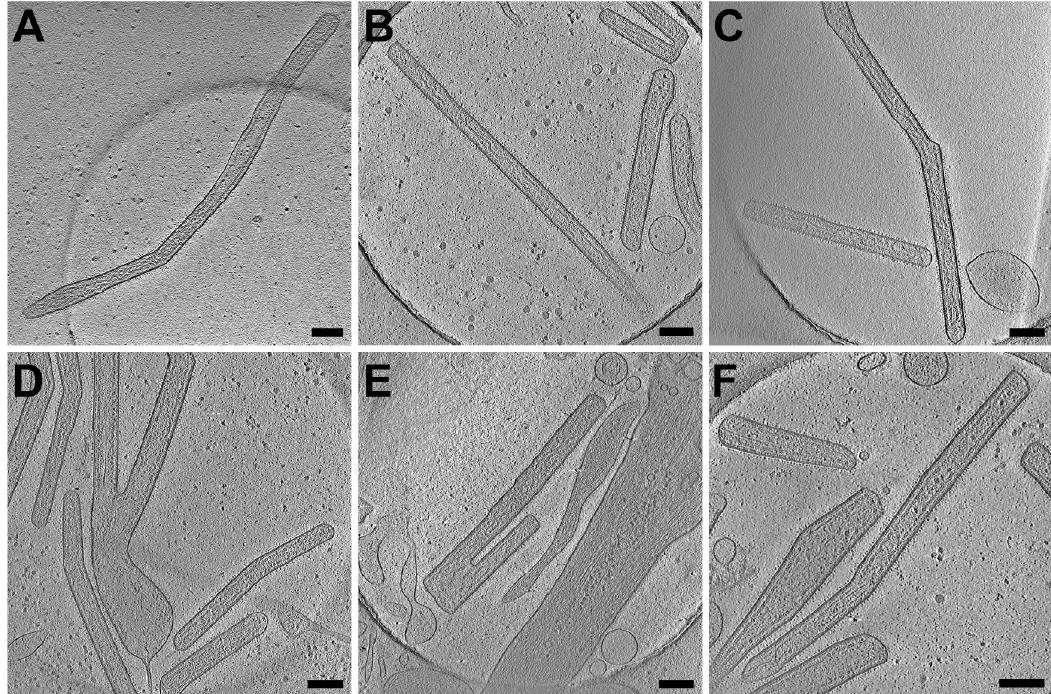
Figure 3. Cryo-ET of released RSV filaments from RSV-infected cells. ( A – F ) Cell lines including HeLa ( A , F ) and lung derived cell lines A549 ( B ), MRC-5 ( C ), and BEAS-2B ( D , E ), were infected with RSV A2 strain ( A – D ) or RSV TN strain ( E , F ). Among these samples, filamentous particles were consistently observed under frozen-hydrated conditions. Scale bars are 200 nm.